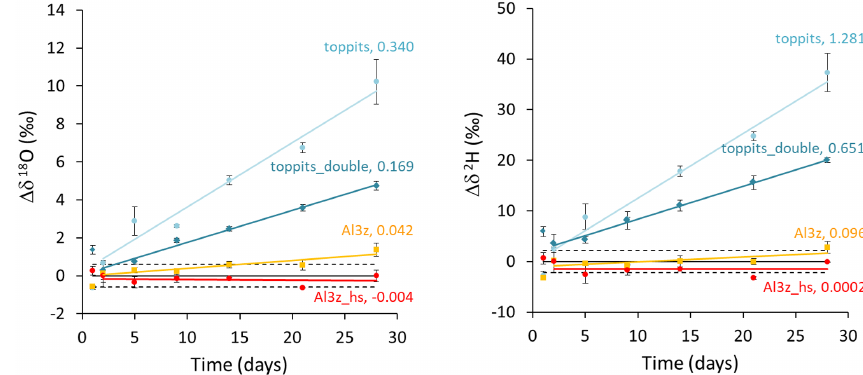
Figure 4. Time series of drift-corrected changes in headspace water vapor stable isotope readings observed in triplicates of single- (light-blue circles) and double-layer (blue diamonds) Toppits® freezer bags as well as of zip-closed-only (orange squares) and additionally heat-sealed (red circles) Al-laminated bags. Numbers in line labels are slopes of the trend lines and indicate average changes in isotope readings in ‰d − 1 after day 1. Horizontal lines represent baselines (solid lines) and reference water vapor standard deviations of ± 0 . 60‰ and ± 2 . 14‰ for δ 18 O and δ 2 H, respectively (dashed lines). Table 2. Characteristics of changes in weight and isotope readings and model-derived isotope fractionation factors. Bag ID Weight loss δ 18 O δ 2 H enrichment Ratio of Model-derived Model-derived Ratio of rate enrichment rate (‰d − 1 ) mean isotope isotope deviations (g ( m 2 d ) − 1 ) rate (‰d − 1 ) enrichment fractionation fractionation of α from rates factor α 18 O factor α 2 H unity toppits 0 . 837 ± 0 . 016 0 . 340 ± 0 . 021 toppits_double 0 . 449 ± 0 . 014 0 . 169 ± 0 . 007 0 . 651 ± 0 . 031 Al3z 0 . 119 ± 0 . 004 0 . 042 ± 0 . 008 0 . 0959 ± 0 . 0353 Al3z_hs 0 . 026 ± 0 . 002 − 0 . 004 ± 0 .